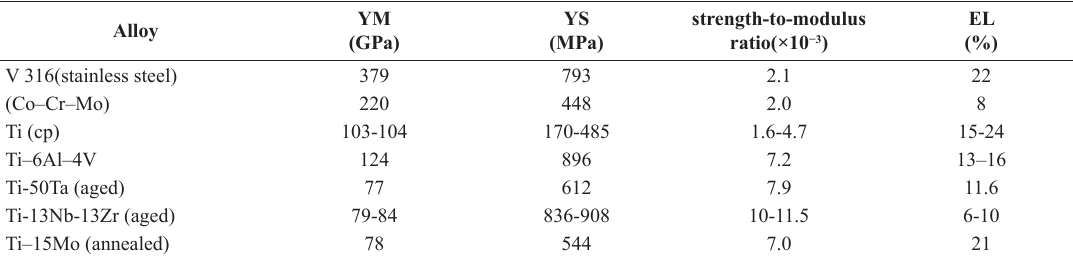
Table 1. Mechanical properties of typical biomaterials 24 .